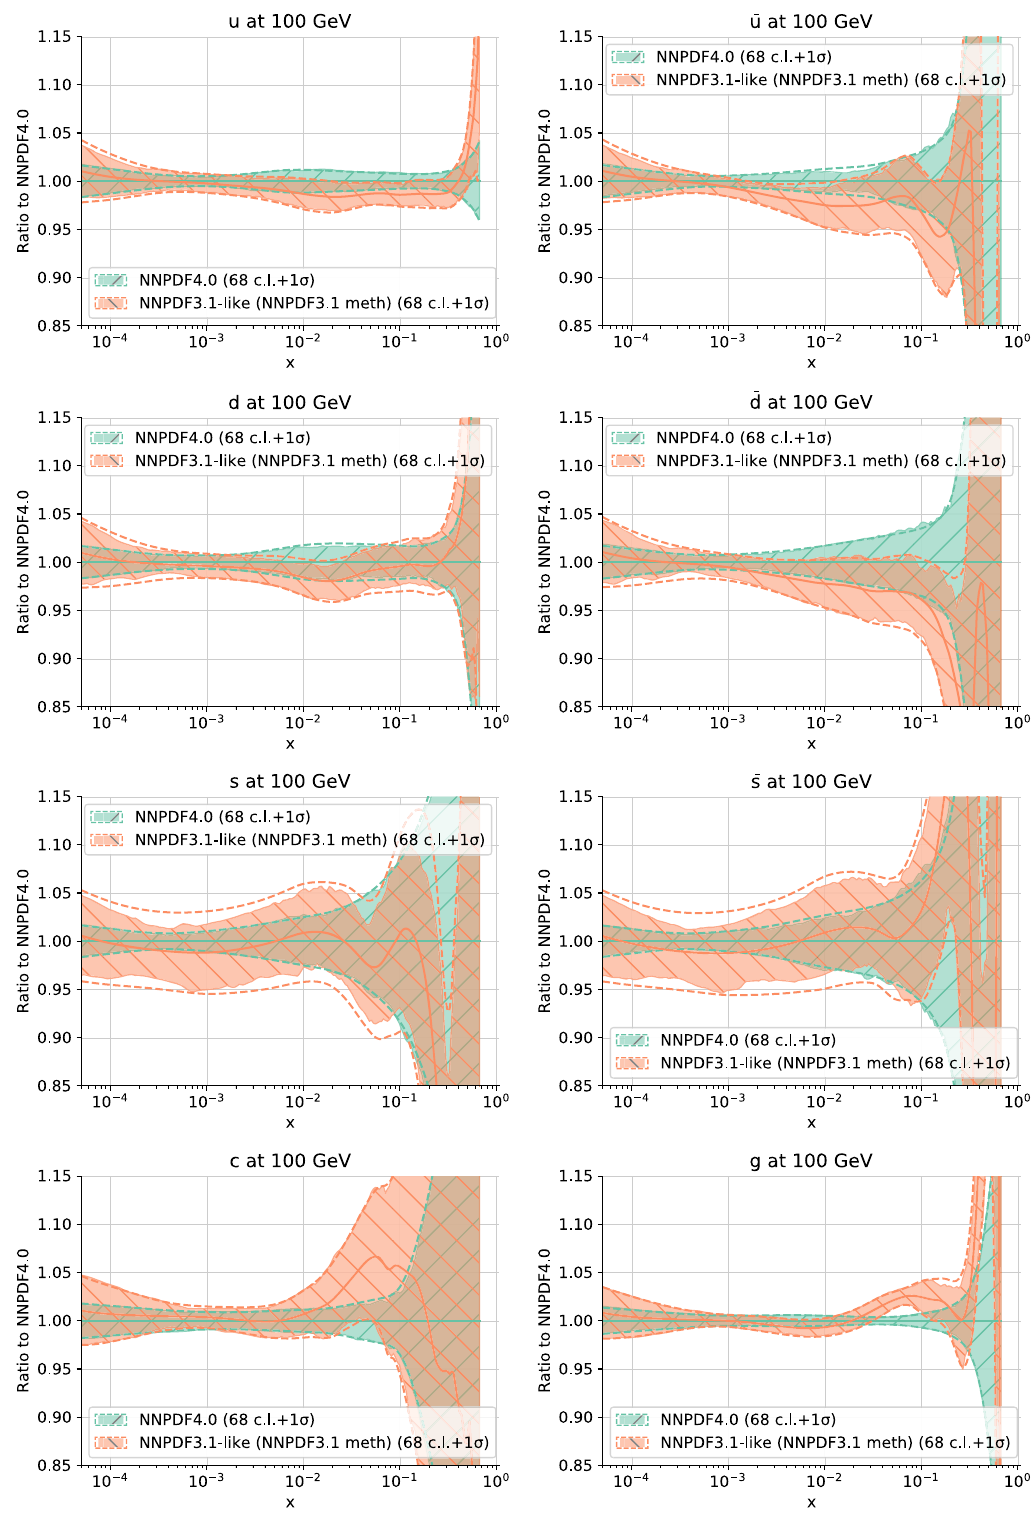
Fig. 32 Same as Fig. 17 but now comparing NNPDF4.0 to NNPDF3.1-like instead of the published NNPDF3.1. The NNPDF3.1-like PDFs shown here define the NNPDF3.1 baseline which will be used in all subsequent plots in this